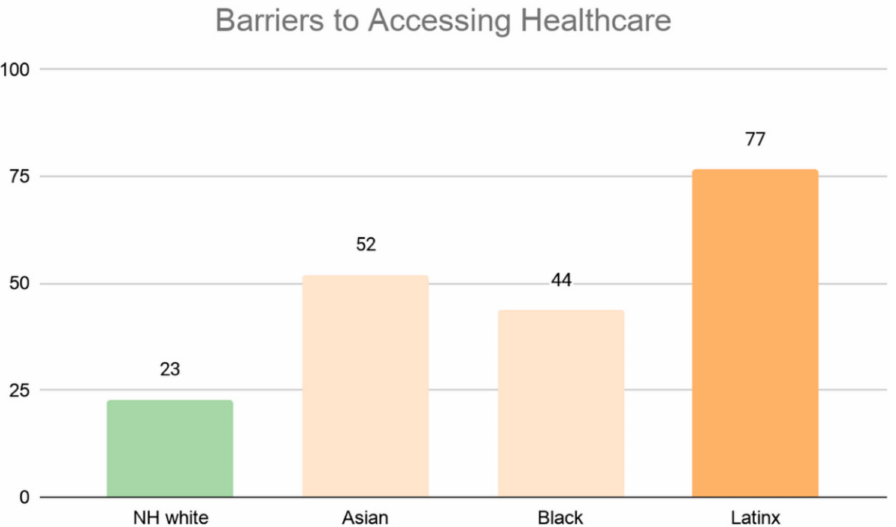
Figure 12. Average barriers to accessing health index by Los Angeles County’s neighborhood’s racial